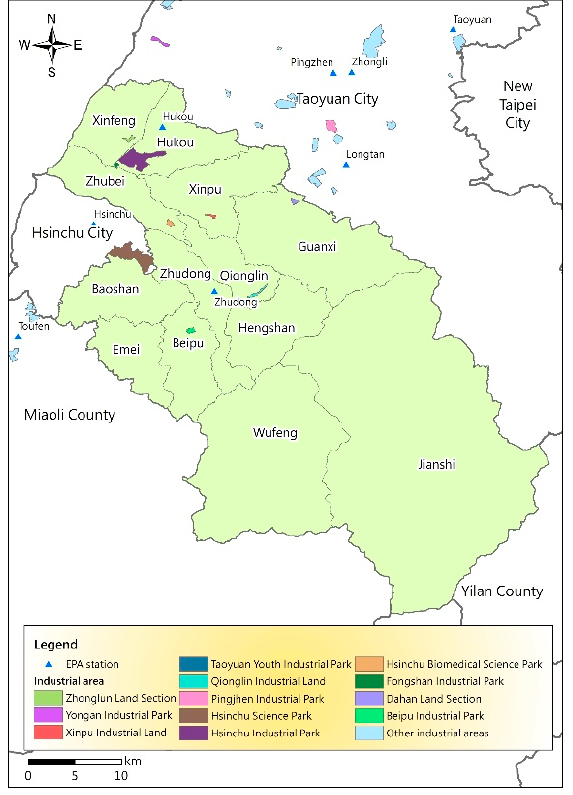
Figure 7. Map of industrial areas and air quality stations.